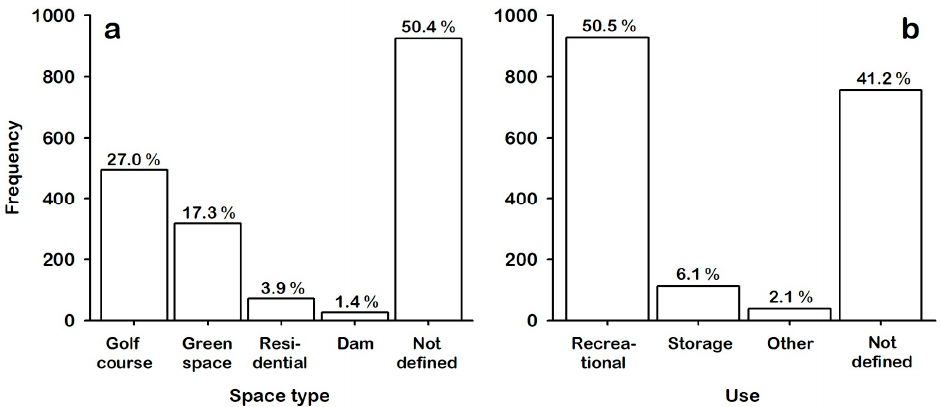
Figure 3. Total frequencies for ( a ) the type of space where blue spaces are located and ( b ) their predominant use. predominant